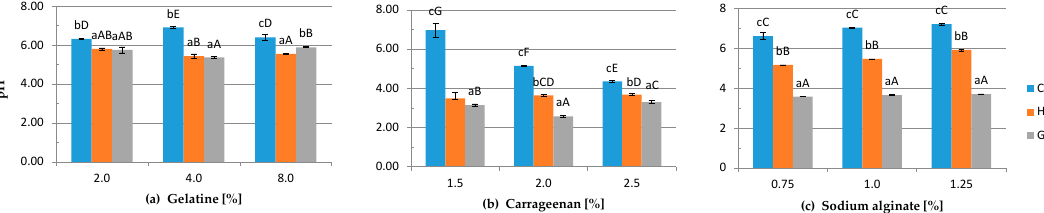
Figure 2. The effects of using DC on the pH of: ( a ) gelatine, ( b ) carrageenan and ( c ) sodium alginate hydrogels (C-, H-, G-types of gels) with 0.2% ( w / v ) NaCl and different polymer concentrations. Differences between means with the same exponent letter are not significant at a p-level value of <0.05. a–c lower case letters indicate differences between means with the same polymer concentration for different DC treatments; A–G capital letters indicate differences between means evaluated with different polymer concentrations and DC treatment.